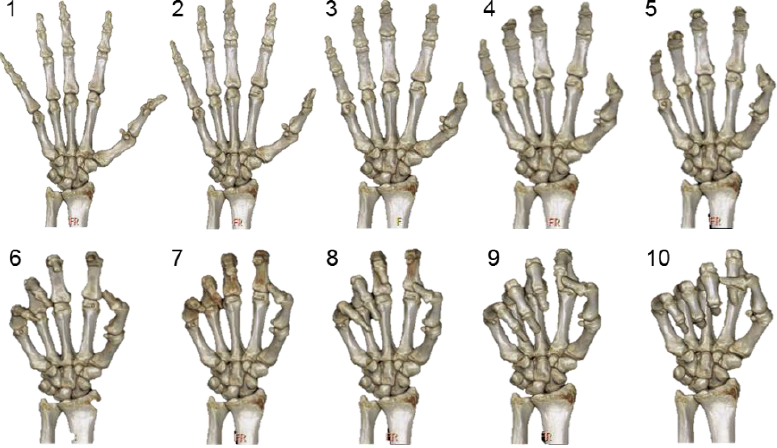
Figure 1. Ten postures from a natural hand-closing motion starting from a fully extended posture (Posture 1) and ending at a fist posture (Posture 10) to estimate hand joint centers, adopted from our previous paper [15].